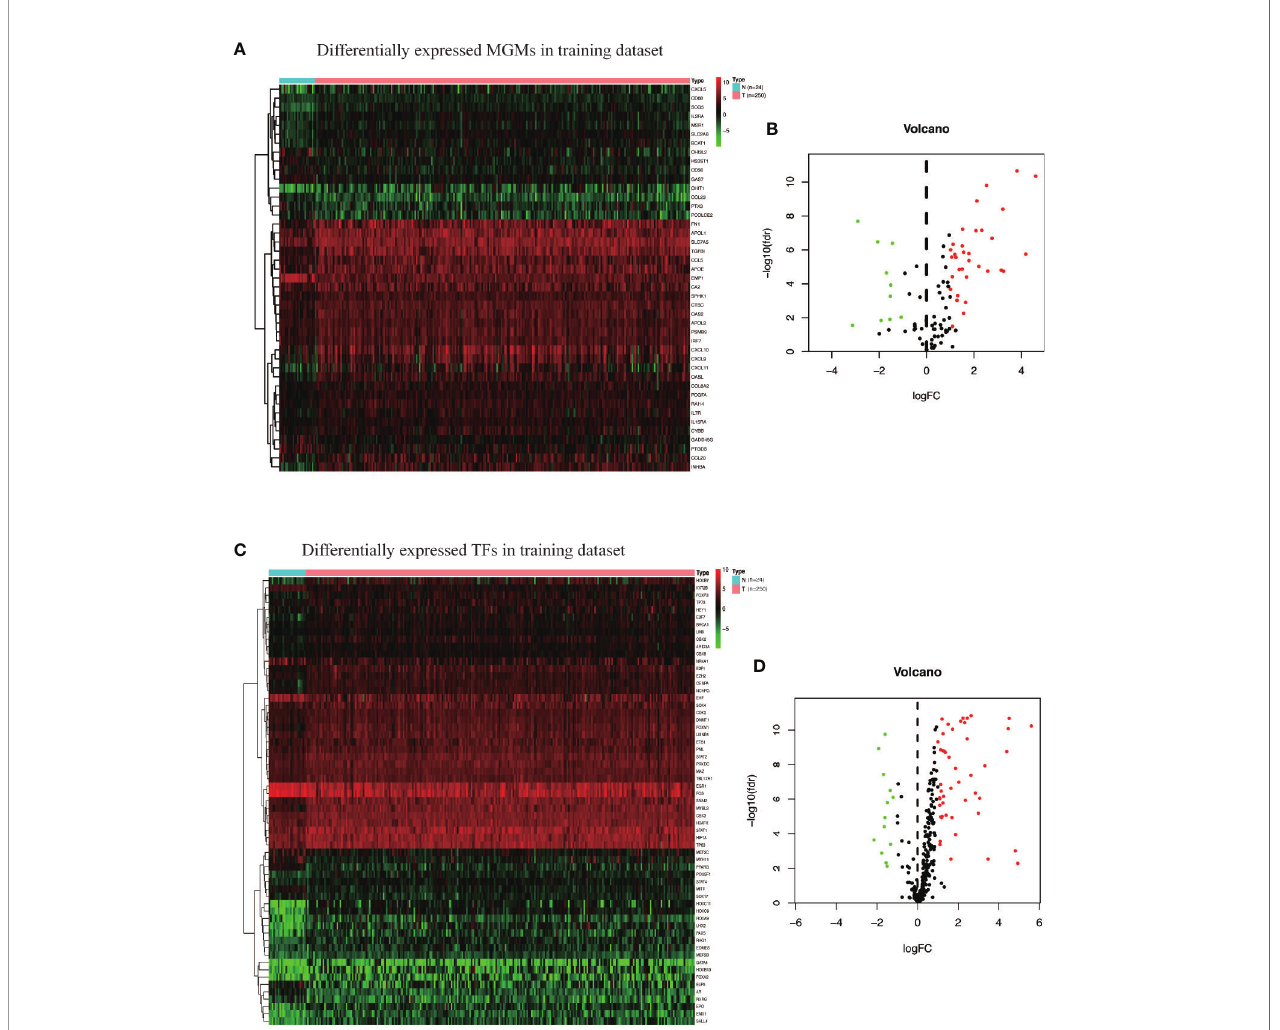
FIGURE 2 | Identi fi cation of differentially expressed MGMs and TFs in the training dataset. (A, B) Heat map and volcanic map of 43 differentially expressed MGMs in the training dataset. (C, D) Heatmap and volcanic map of 61 differentially expressed TFs in the training